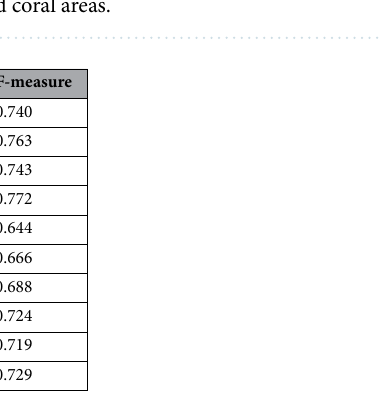
Table 1. Performances of U-Net and pixelwise CNN based on five-fold cross-validation.